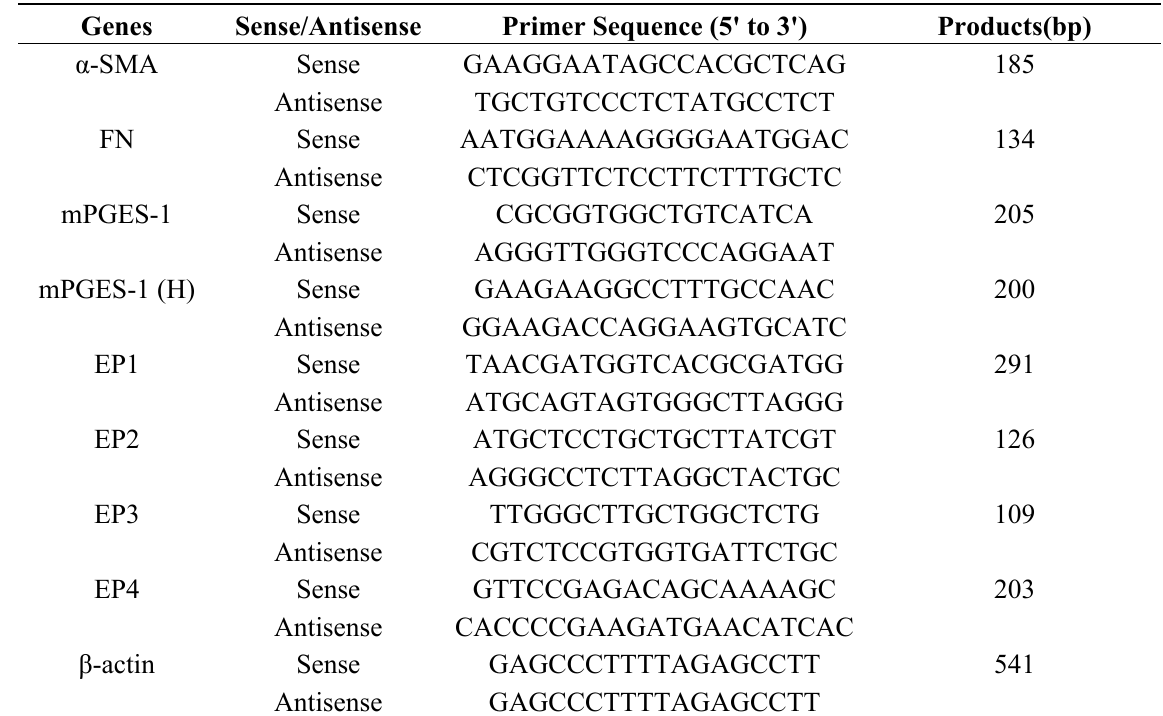
Table 1. RT-PCR primers and